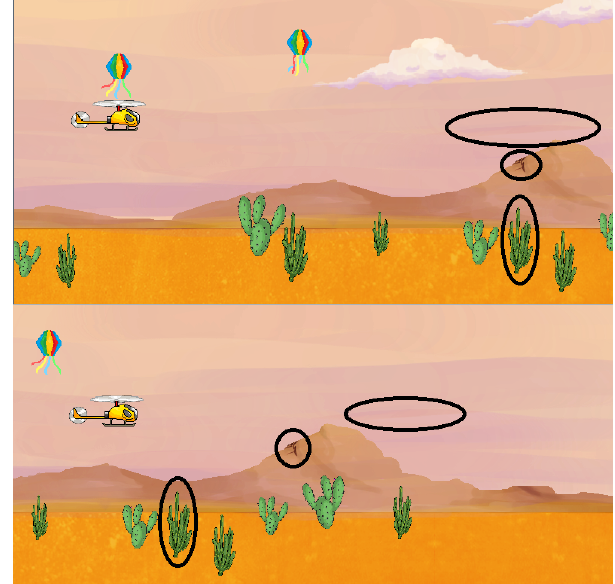
Fig. 4: The parallax effect. On the top image, we circled three background elements in an instant t , each of which in a different background layer. On the bottom image, we showed the same background elements in an instant t + d , thus indicating that they move at different speeds.